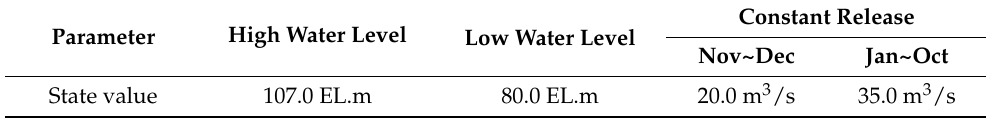
Table 6. The evaluation of the satellite-based water level and simulated water level.